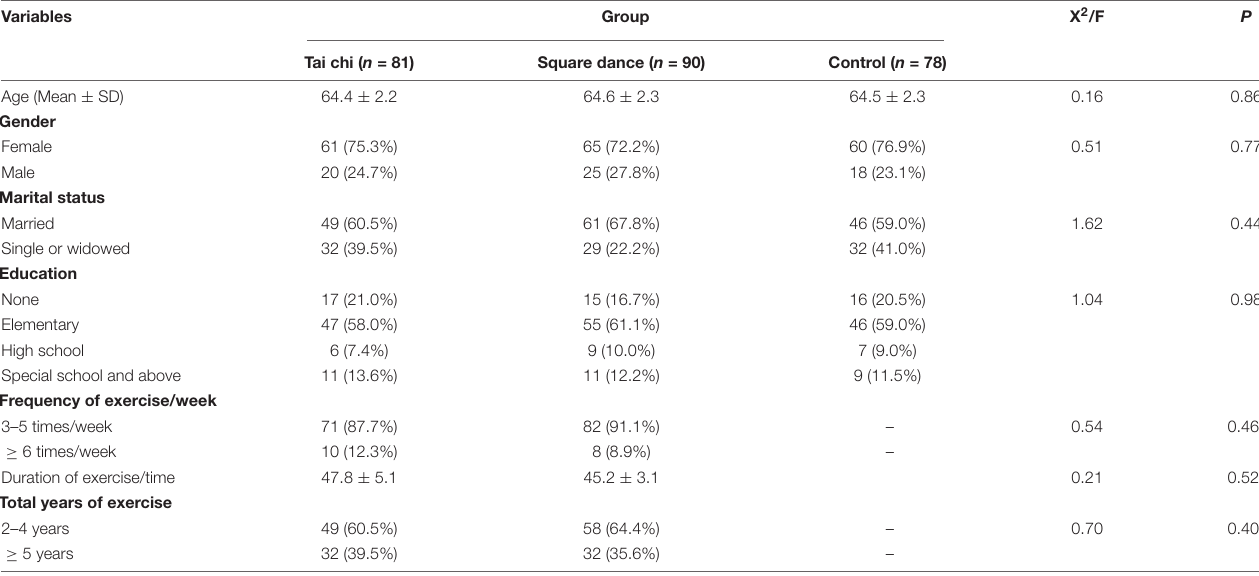
TABLE 1 | Demographics of the participants in the three groups ( n = 249).